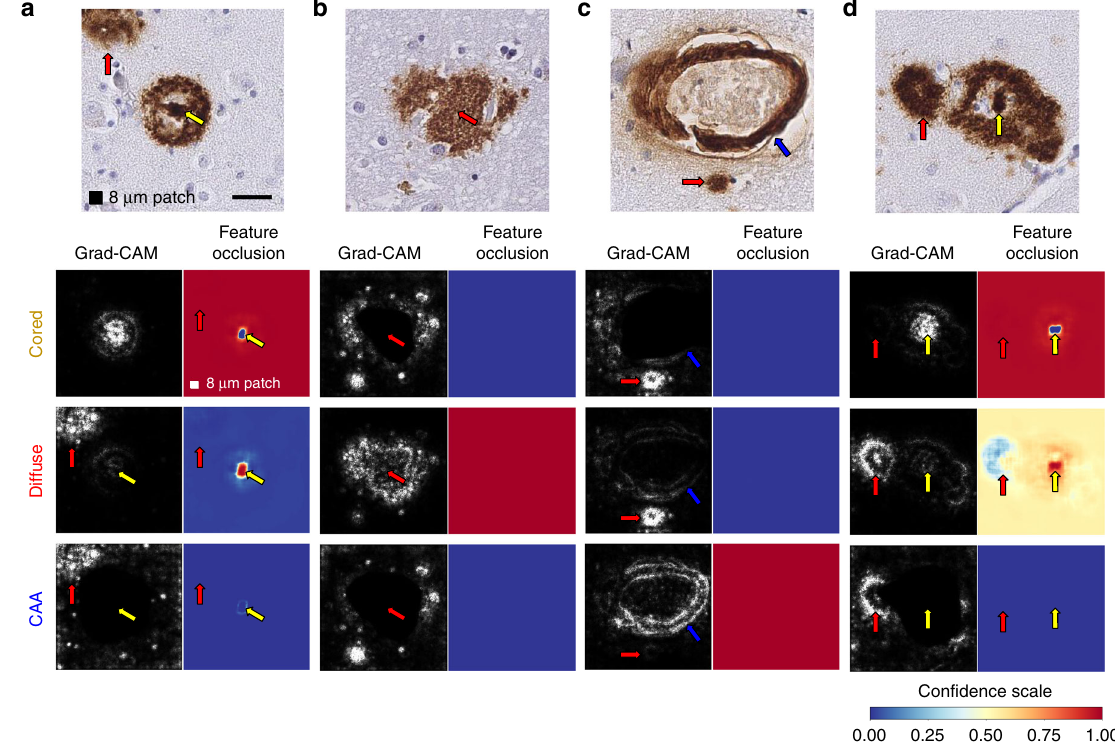
Fig. 7 Model interpretability studies using machine-learning introspection techniques. a A cored plaque example (top row, yellow arrow). For the task of cored-plaque prediction, the activation map (by Guided Grad-CAM; left, second row) and the feature occlusion map (right, second row) identify the amyloid core (yellow arrow) as the de fi ning morphological feature. By contrast, the diffuse stained region (red arrow) only arises as a salient feature during diffuse-plaque and CAA prediction tasks (third and fourth rows, respectively). b Diffuse plaque example where activation and feature occlusion maps focus on ill-de fi ned amorphous amyloid contours for diffuse-plaque classi fi cation task (third row). c CAA example, where the CAA task ’ s activation and feature occlusion maps (fourth row) highlight amyloid ring pixels within the media of the cortical vessel (blue arrow), while for cored and diffuse tasks the small punctate IHC staining is considered salient (red arrow; second and third rows). d Example containing both diffuse (red arrow) and cored (yellow arrow) plaques in the same tile illustrate the difference between activation and feature occlusion maps. Con fi dence scales for feature occlusion maps represent the CNN ’ s prediction con fi dence on the occluded image, with red being the most con fi dent and blue the least. Scale bar = 25 μ